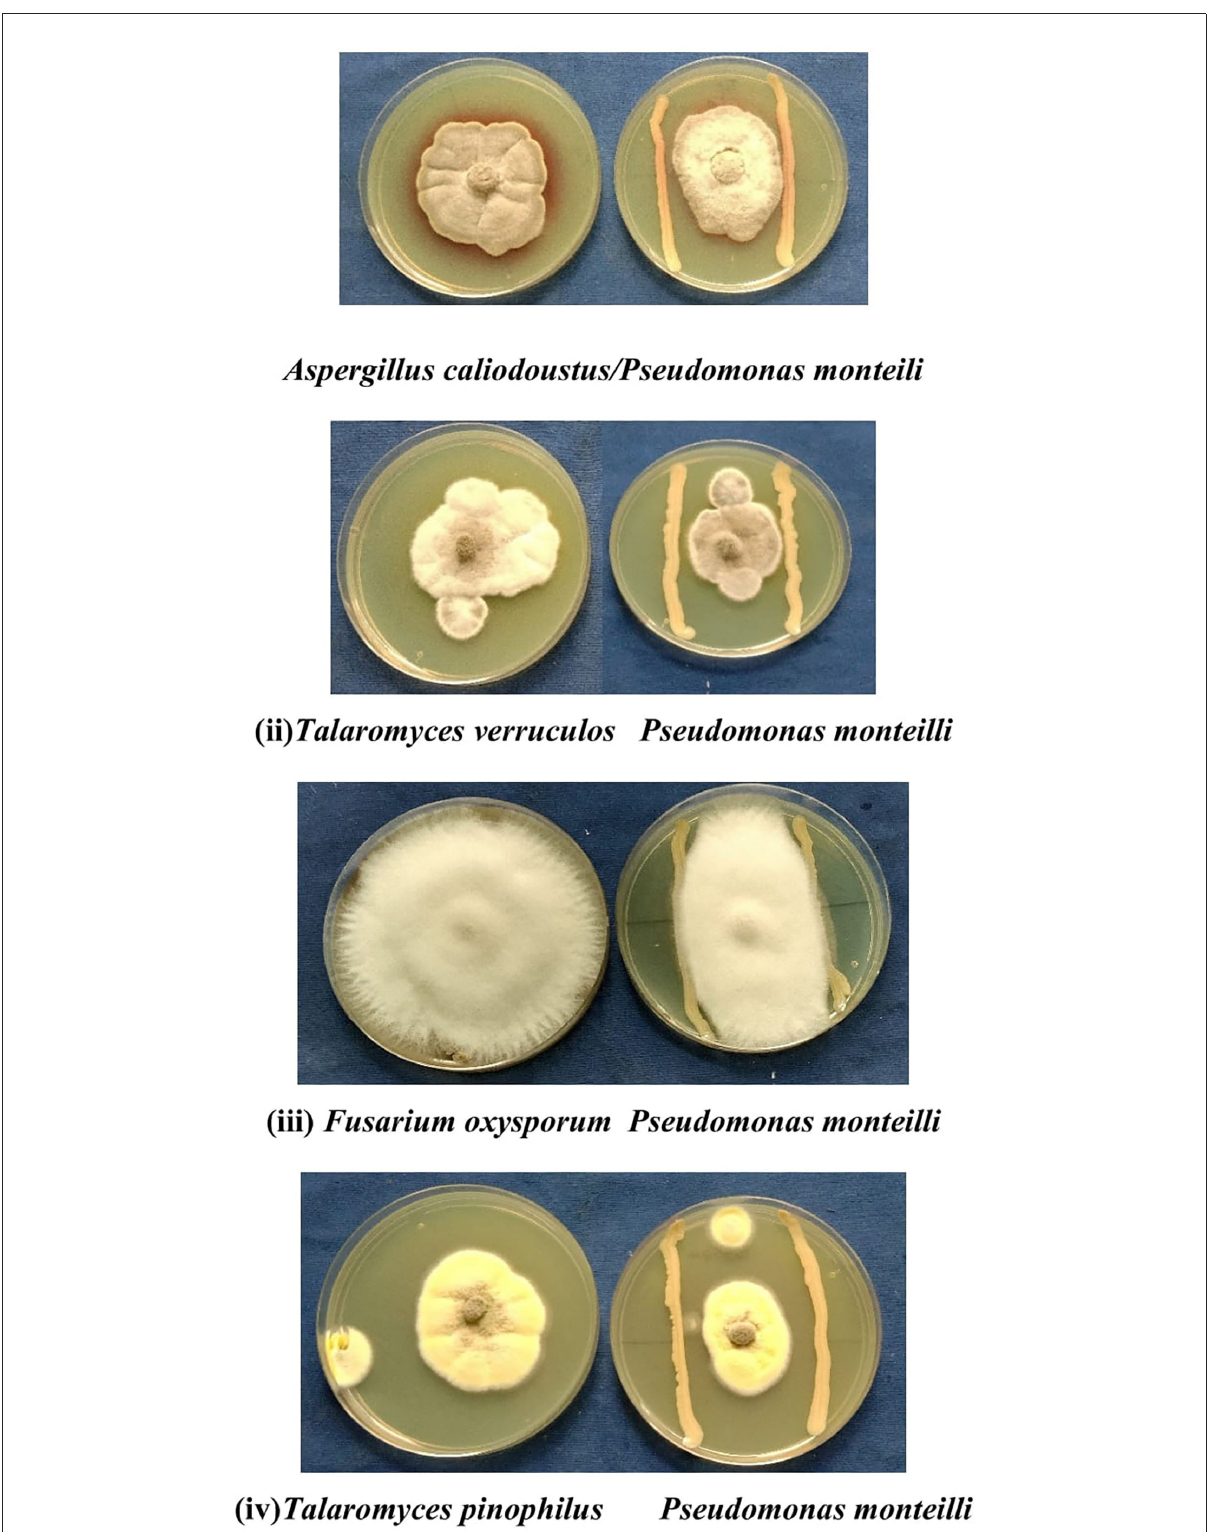
FIGURE8 Four representative examples of in vitro dual culture assays against fungus (i) Aspergillus calidoustus, (ii) Talaromyces verruculosus, (iii) Fusarium oxysporum, (iv) Talaromyces pinophilus for bacterial isolate Pseudomonas monteilli. It varied from 41 to 65% against different fungus such as A. calidoustus (65%), F. oxysporum (41.66%), T. pinophilus (65%), T. verruculosus